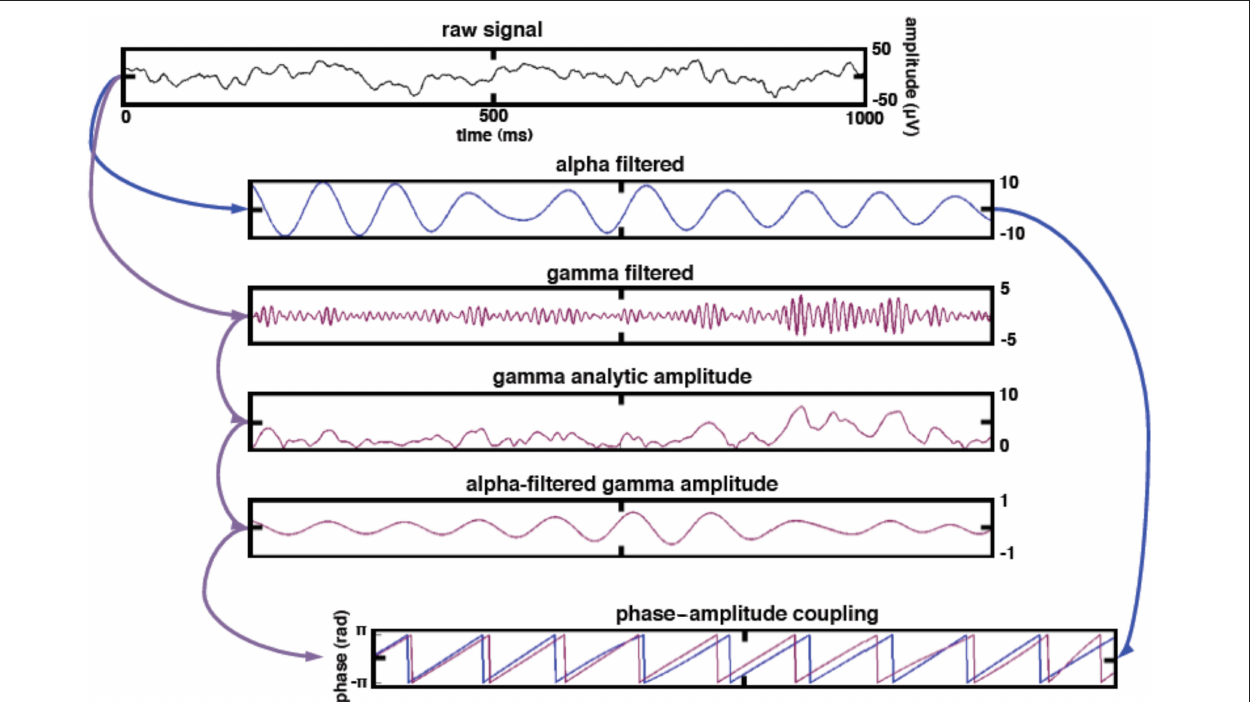
Figure 2 | Data processing schematic for calculating phase–amplitude coupling. To estimate alpha PAC, the raw signal was band-pass filtered into both a low-frequency alpha (8–12 Hz) component as well as a high-frequency gamma (80–150 Hz) component. We then extracted the amplitude of the band-passed